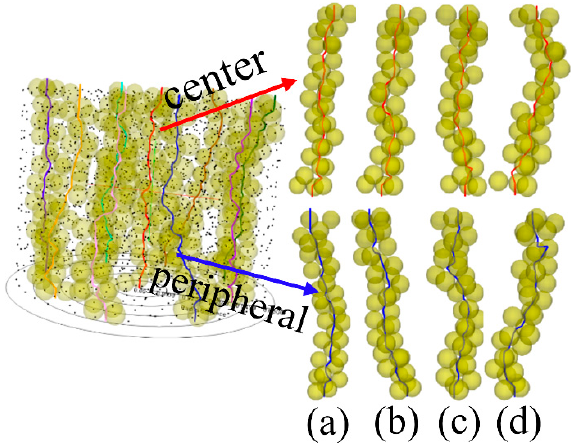
Figure 10. Airflow path distribution under different vertical pressure: ( a ) 0 kPa ( b ) 50 kPa ( c ) 150 kPa ( d ) 250 kPa.